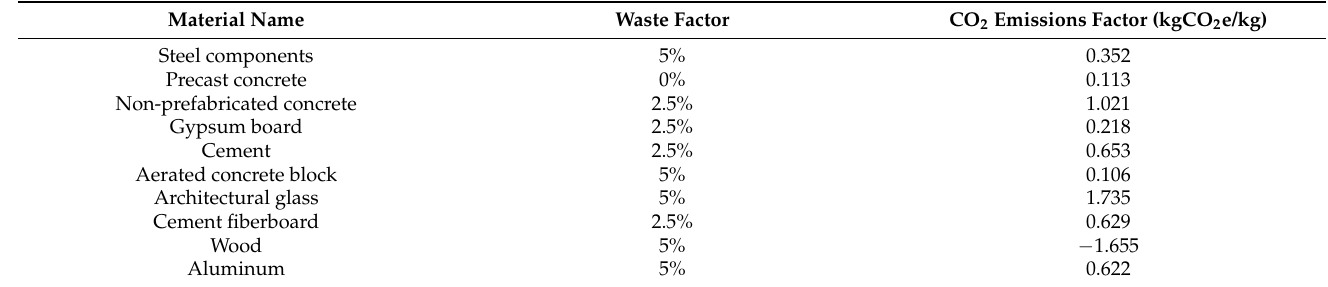
Table 2. Construction material waste factors and carbon emissions factors.